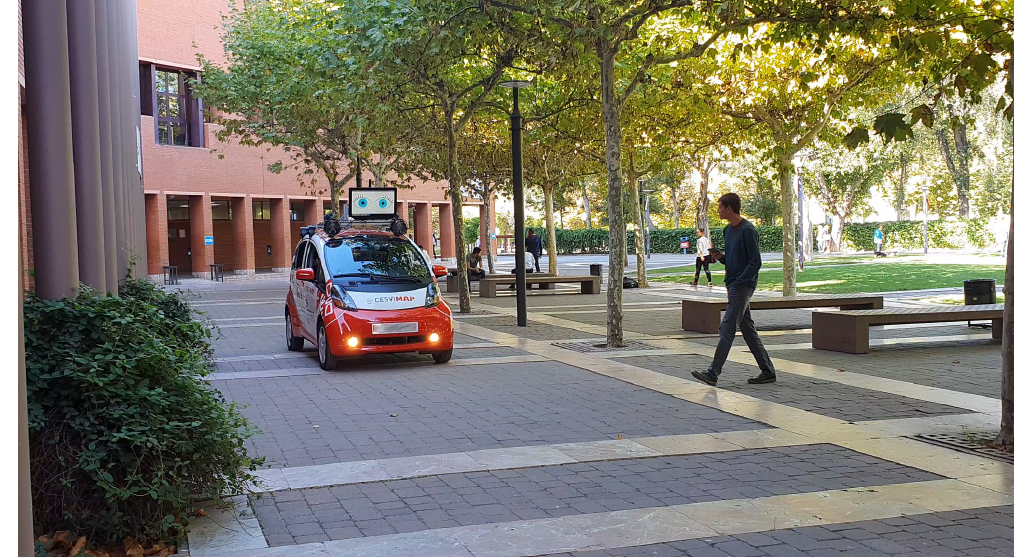
Figure 13. Experimenting with different human–machine interfaces